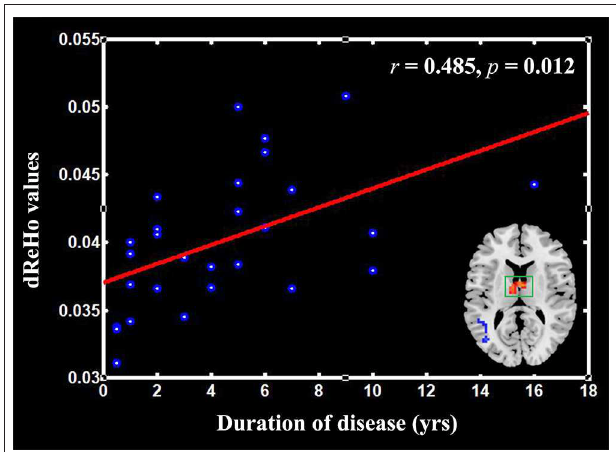
FIGURE 2 | Scatter plots of the mean dReHo of the clusters in the thalamus positively correlated with the pain duration in the patients with trigeminal neuralgia